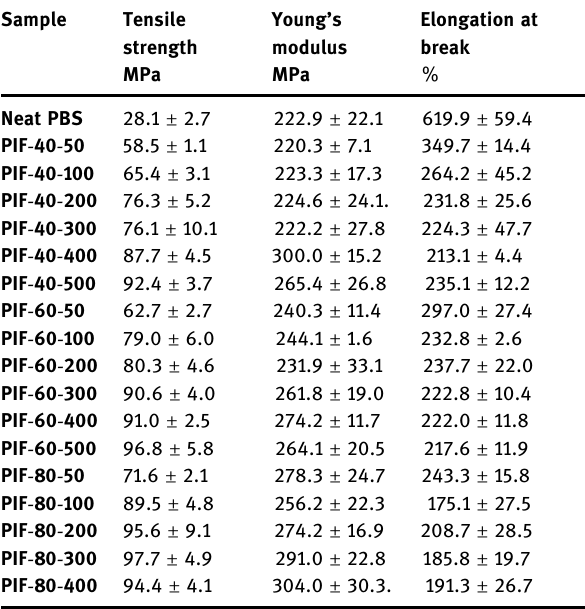
Table A1: Tensile properties of the neat PBS and PIF - processed PBS samples under various processing